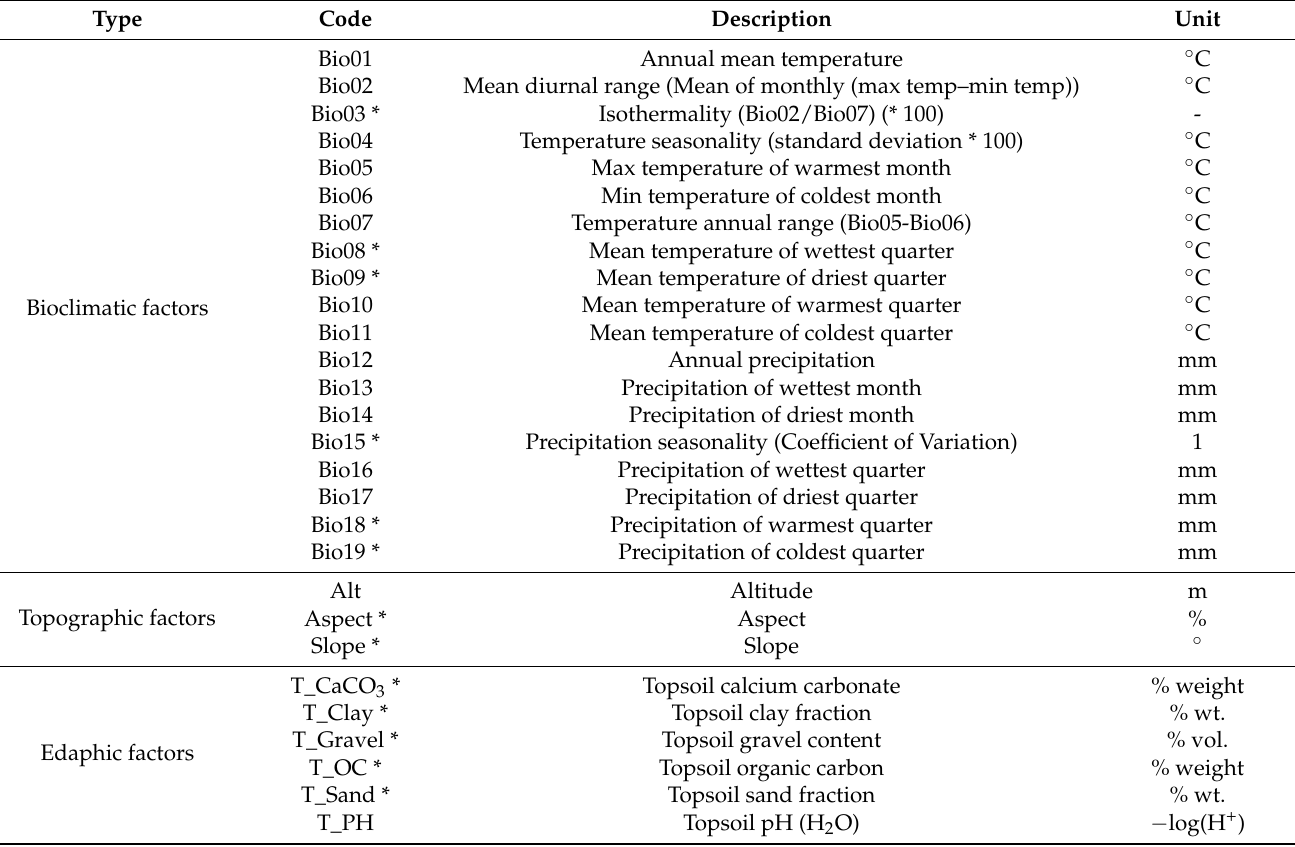
Table 1. List of 28 environmental variables used in the model development. The variables selected for analysis are marked with an asterisk